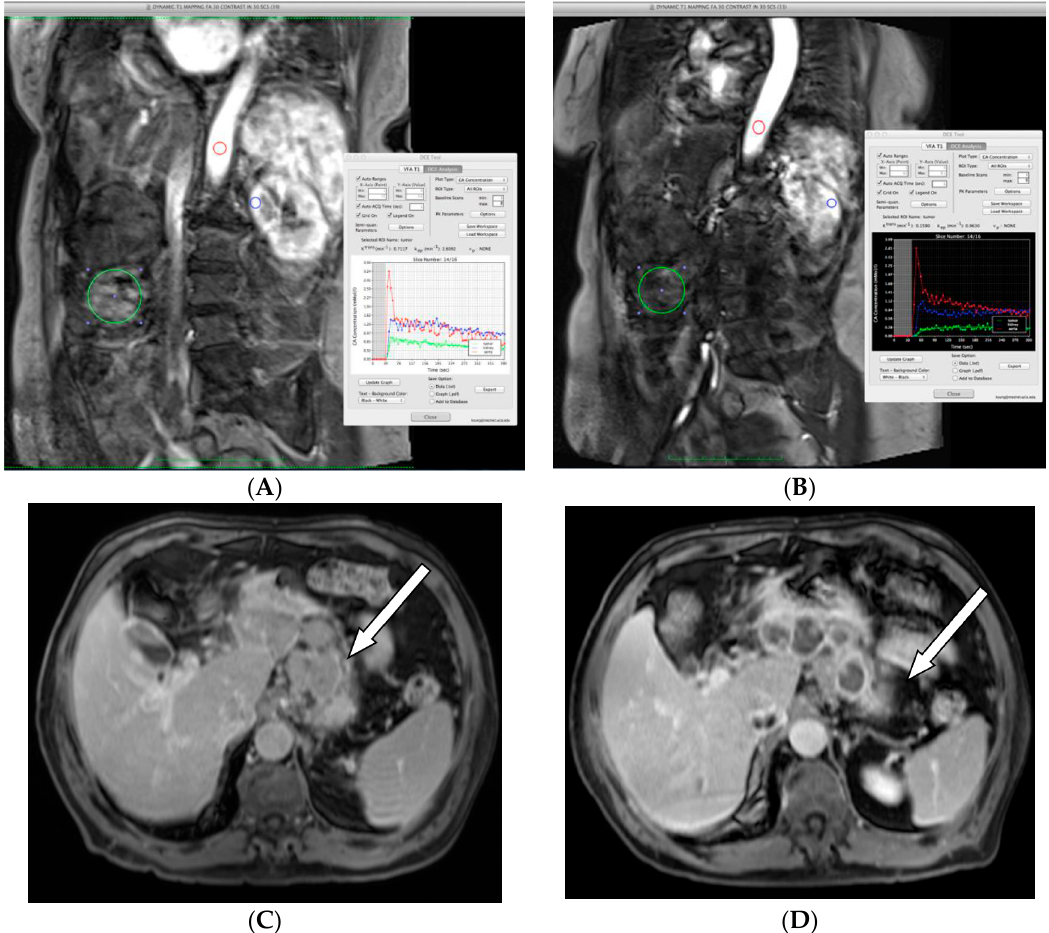
Figure 3. Effect of mipsagargin on blood flow metrics in hepatocellular carcinoma (HCC; A and B